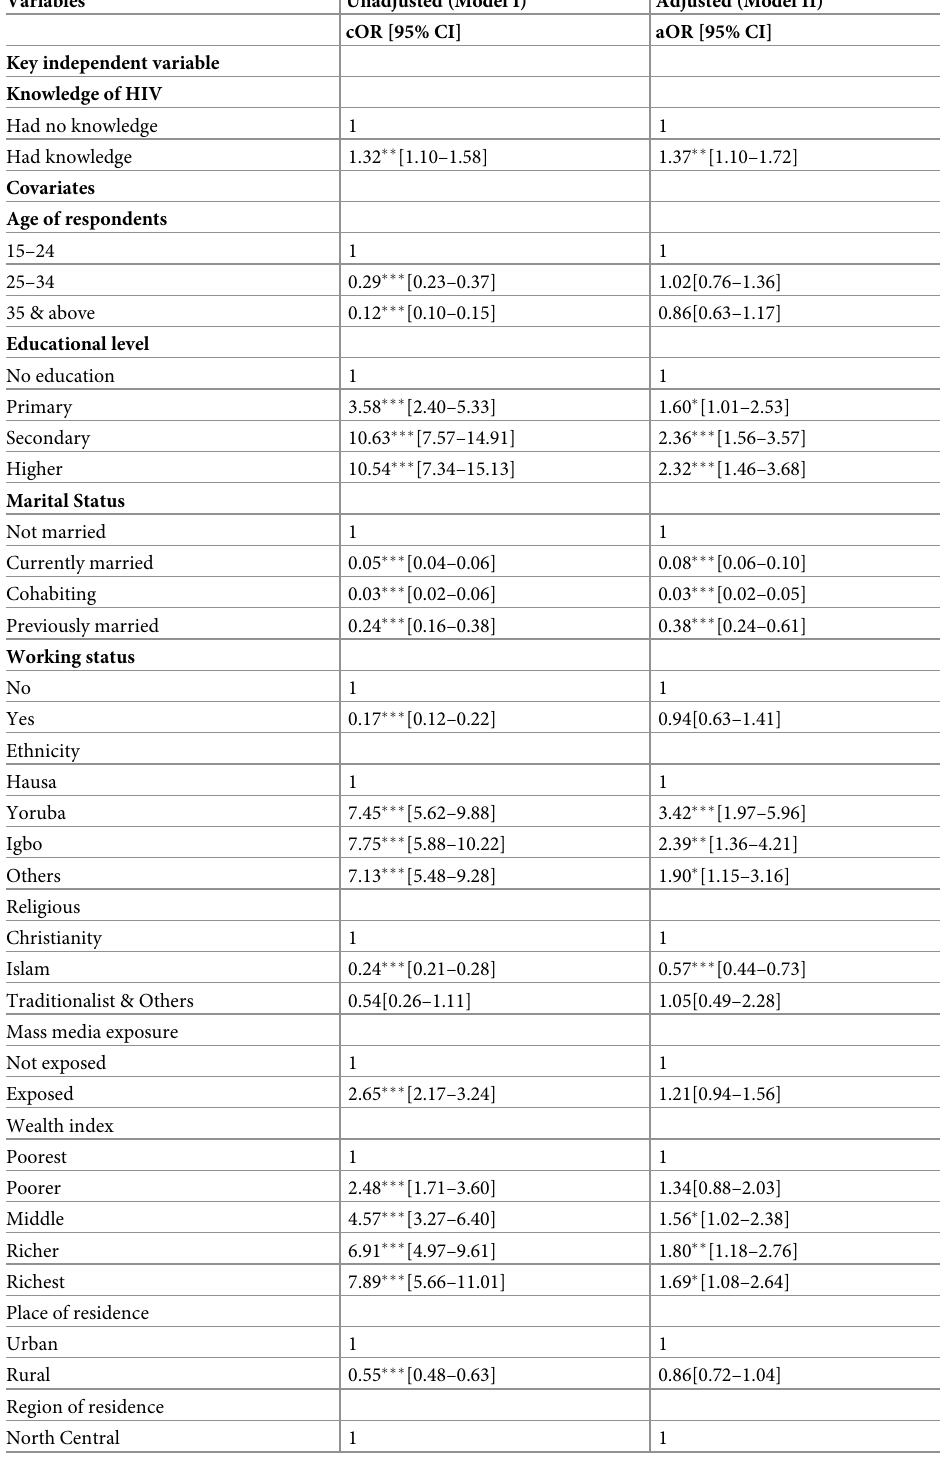
Table 2. Bivariate and multivariable logistics regression analysis of knowledge of HIV and consistent condom use among sexually active men in Nigeria (N =